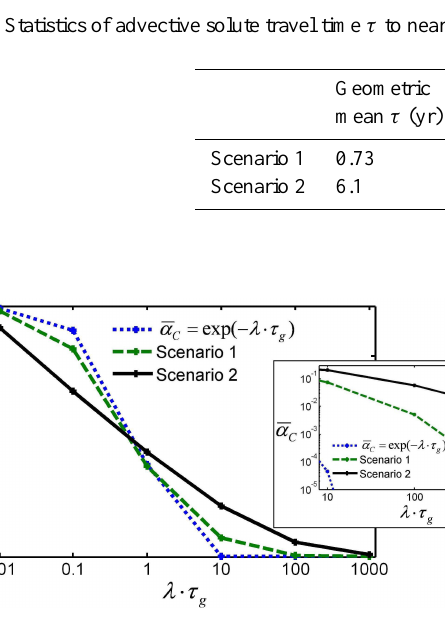
Fig. 3. Total (catchment-average) mass delivery fraction to near- est surface water from all upstream input locations in the Forsmark catchment, ¯ α C , under the assumption of constant λ for the two con- sidered scenarios regarding K variability, and for a calculation ap- proach where the travel time variability around the geometric mean τ g is neglected so that ¯ α C = exp (cid:0) − λτ g (cid:1) . The small inset graph shows in clearer axis log-scale the ¯ α C results for large character- istic attenuation products λτ g